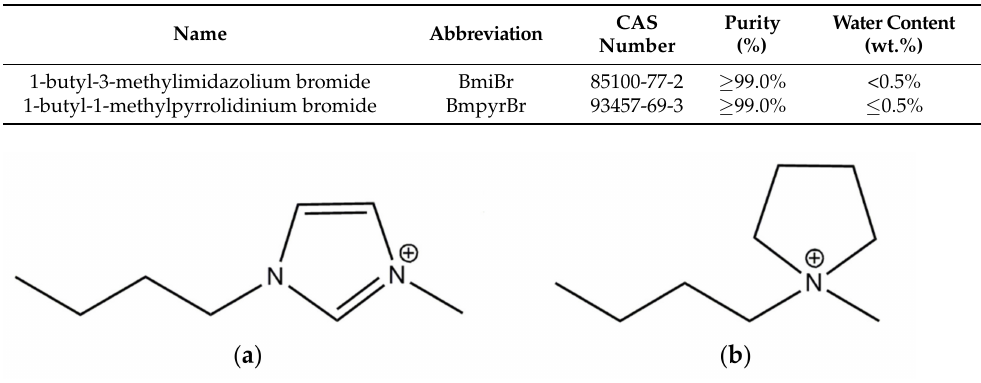
Table 1. Ionic liquids (ILs) with bromide anion used in natural rubber (NR)